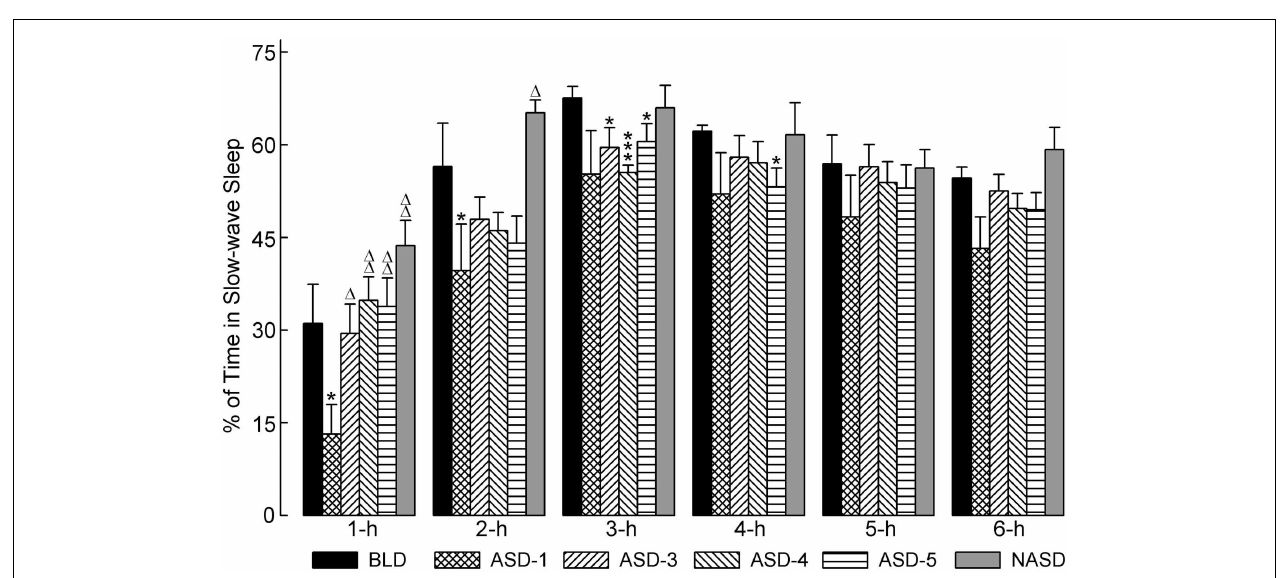
exposure (ASD-1), day 3 of AS exposure (ASD-3), day 4 of AS exposure (ASD-4), day 5 of AS exposure (ASD-5), and no exposure to AS day (NASD). *Represents a significant difference from BLD: * p < 0.05, ** p < 0.01, *** p < 0.001. ∆ represents a significant difference from ASD-1: ∆ p < 0.05, ∆∆ p < 0.01, ∆∆∆ p < 0.001.